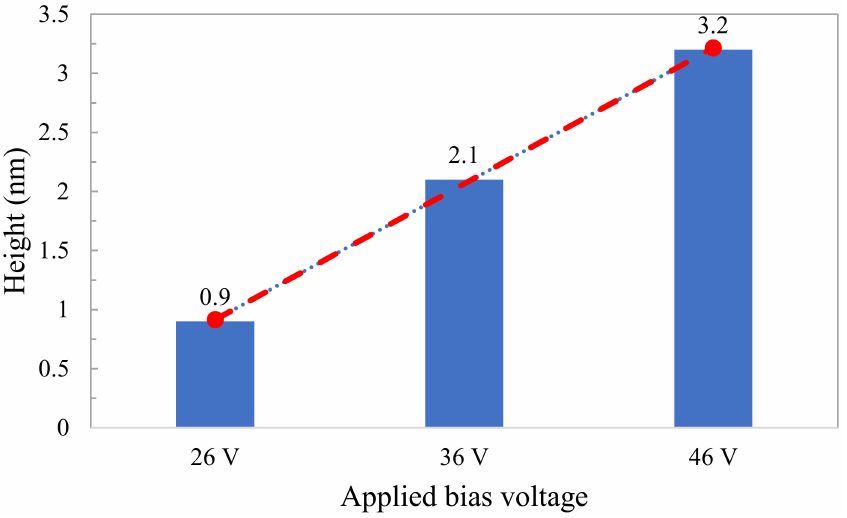
Figure 12. Height of oxide lines at di ff erent applied bias